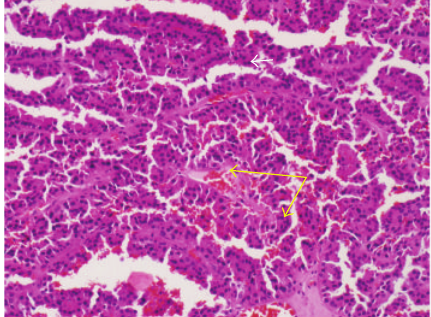
Figure 5: Papillary renal cell carcinoma with oncocytic features (hematoxylin and eosin stain, high magnification). Note distinct papillae with eosinophilic cytoplasm (bottom arrow), with fibrovas- cular core (top